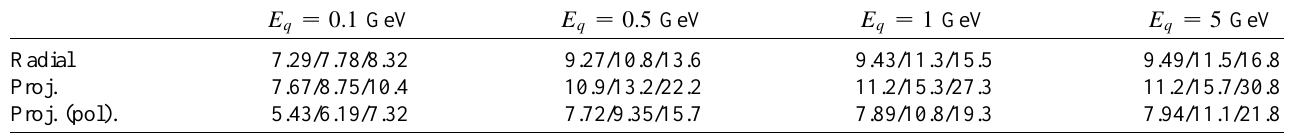
TABLE II. rms values for the same distributions, energies, and cutoff levels as in Table I. (cid:69) (cid:113) (cid:173) (cid:48)(cid:46)(cid:49) GeV (cid:69) (cid:113) (cid:173) (cid:48)(cid:46)(cid:53) GeV (cid:69) (cid:113) (cid:173) (cid:49) GeV (cid:69) (cid:113) (cid:173) (cid:53)